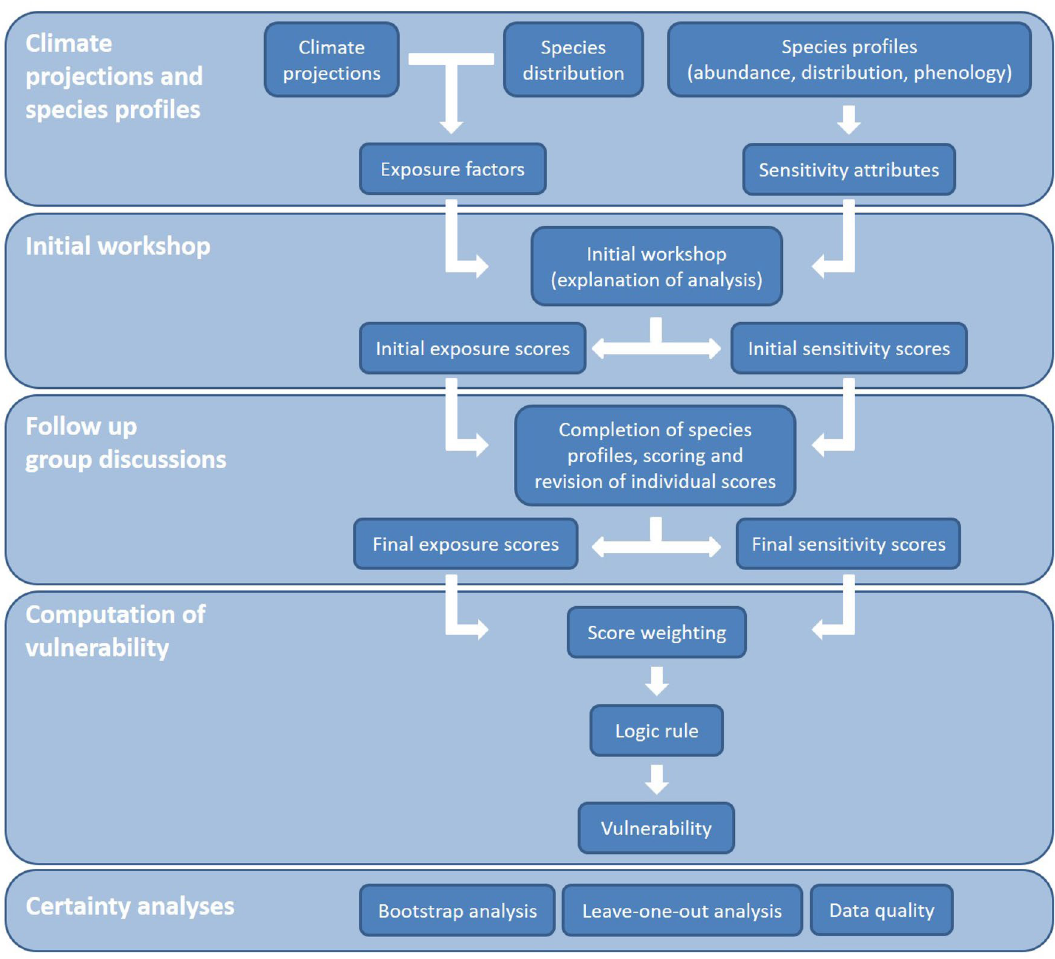
Figure 2. Flowchart of the Climate Vulnerability Assessment (Modified from a previous study 39